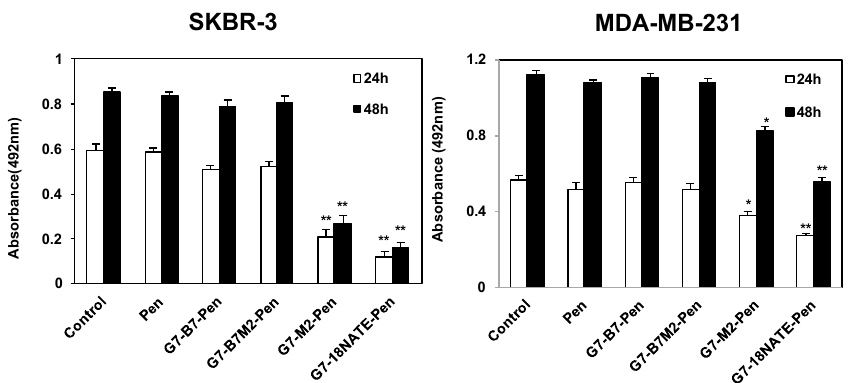
Figure 3. Effect of G7-peptides on proliferation of ( left ) SKBR-3 and ( right ) MDA-MB-231 cells. Cells were treated with 20 µ M control peptide (Pen) or 20 µ M G7-peptide inhibitors (G7-B7-Pen, G7-B7M2-Pen G7-M2-Pen and G7-18NATE-Pen) for 24 h and 48 h at 37 °C. Cell proliferation was examined with the MTS assay. Values are means ± SEM for at least three independent experiments with duplicate samples. A student ′ s t test was performed between control (no peptide) and G7-peptide treated samples with * p < 0.05, ** p < 0.01.